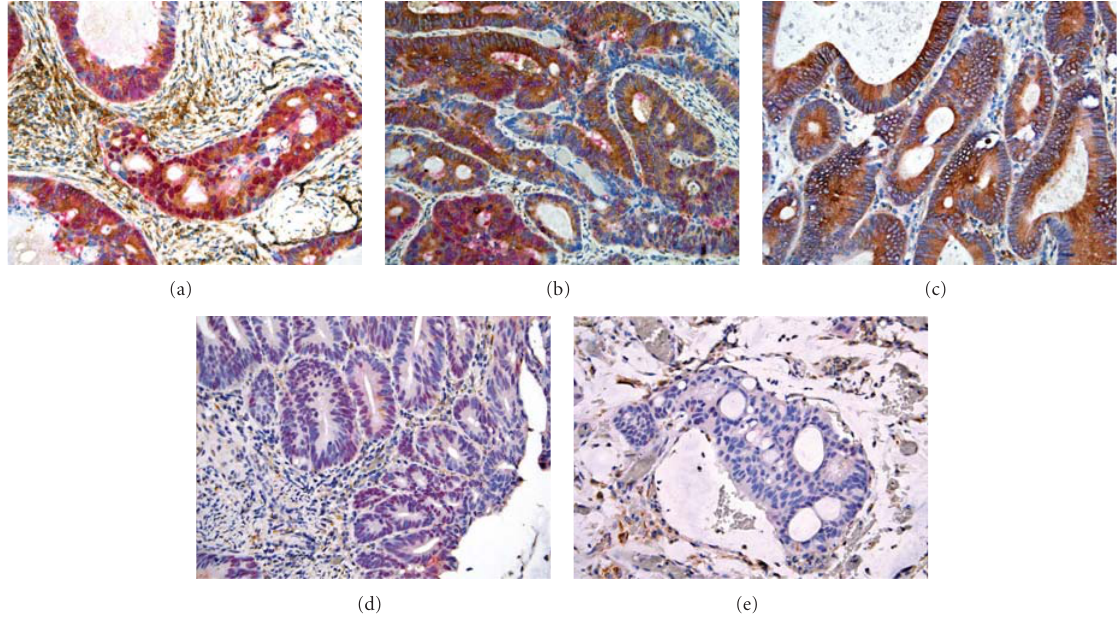
Figure 5: The relationship between Cx43 expression and nuclear beta-catenin expression in colonic adenocarcinoma (original magnification × 200). (a) Coexpression of Cx43 (brown cytoplasmic staining) and nuclear beta-catenin (red nuclear staining). Note. Peritumoral stromal cells exhibited only Cx43 but not beta-catenin reactivity. (b) Tumoral tissue exhibited heterogeneous expression of Cx43 and nuclear beta- catenin. (c) Tumoral tissue with expression of Cx43 only. (d) Tumoral tissue with expression of beta-catenin only. (e) Tumoral tissue with no expression of Cx43 or beta-catenin.